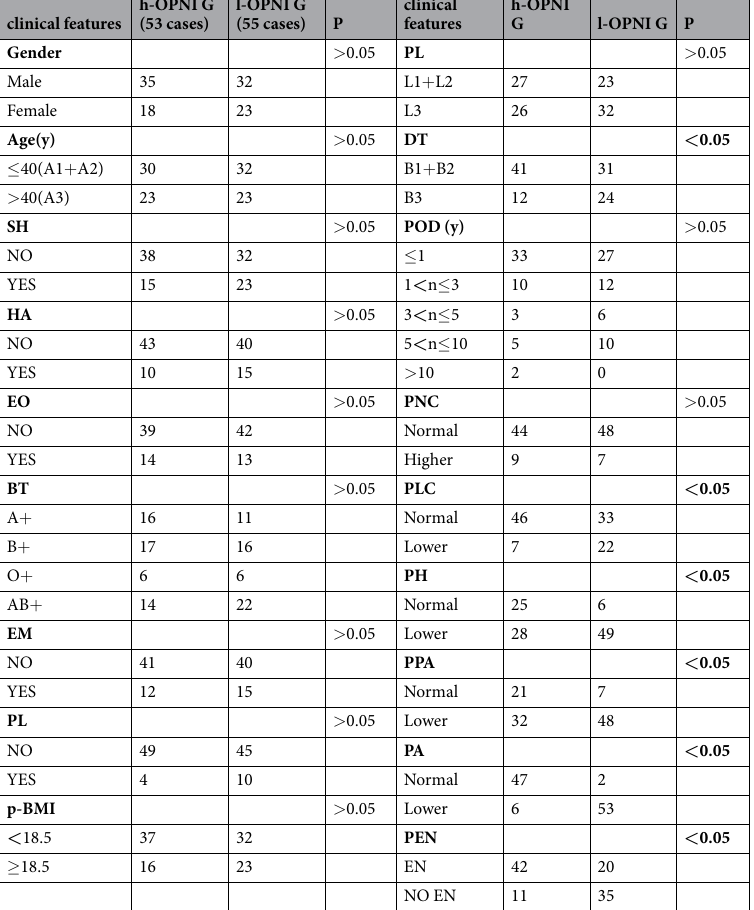
low group (n = 55 < 39.8) high group(n = 53 > 39.8) Total number